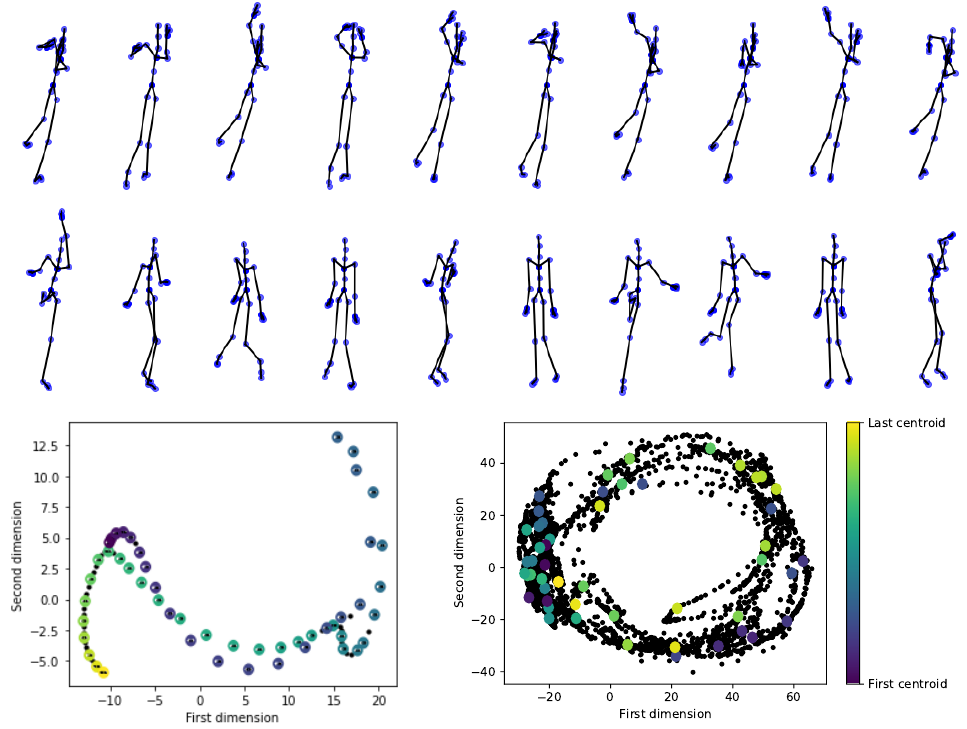
Figure 3. Illustrative results for codebook generation and latent space-based representation (HDM05 and CMU subset datasets). Top: Codebook generation for a Mocap video of the throwing high with the right hand while standing class (HDM05). Middle: Codebook generation for a Mocap record of boxing class (CMU subset). Bottom left: PCA-based latent space for HDM05 video. Bottom right: PCA-based latent space for CMU subset video. The first two components are shown for visualization purposes. Black markers represent the original input Mocap frames (time series). Color markers represent the chosen frames